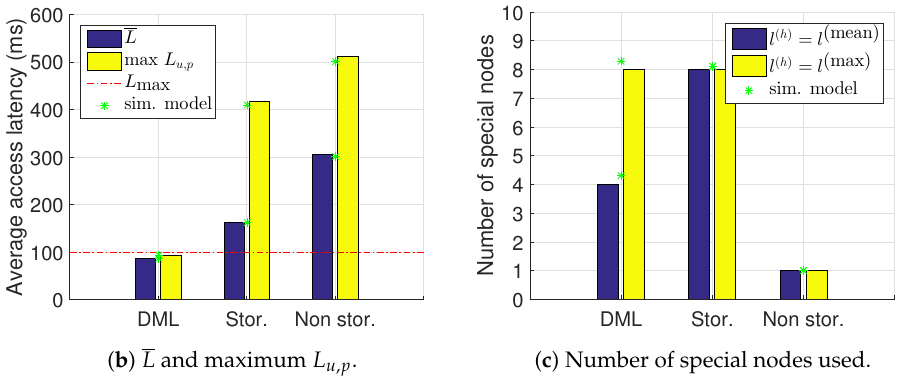
Figure 6. Experimental results in the IoT-LAB Euratech testbed. The validation of the simulation model is displayed in